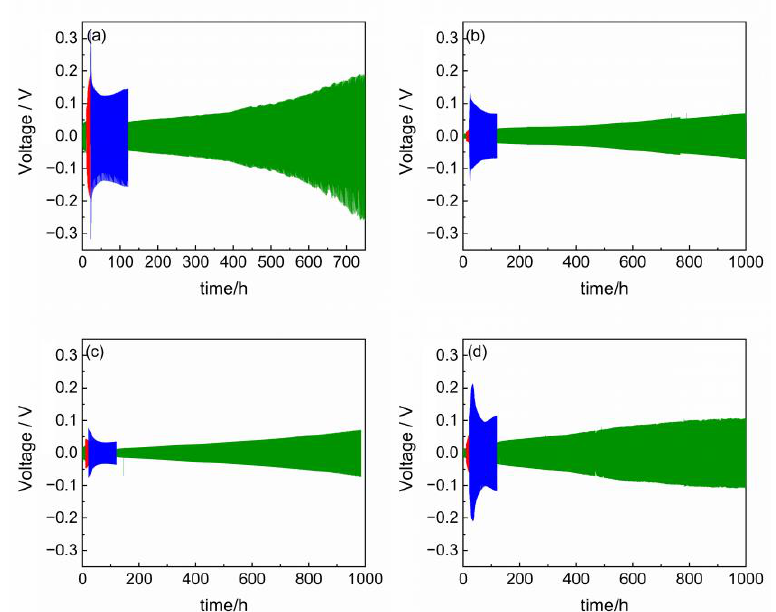
Figure 4. Deposition and stripping cycles of Li||Li symmetric cells with ( a ) PC, ( b ) PC-NH 4 PF 6 , ( c ) PC-TMAPF 6 , ( d ) PC-TEAPF 6 electrolytes at 0.125 mA cm −2 (green), 0.250 mA cm −2 (red) and 0.500 mA cm −2 (blue).